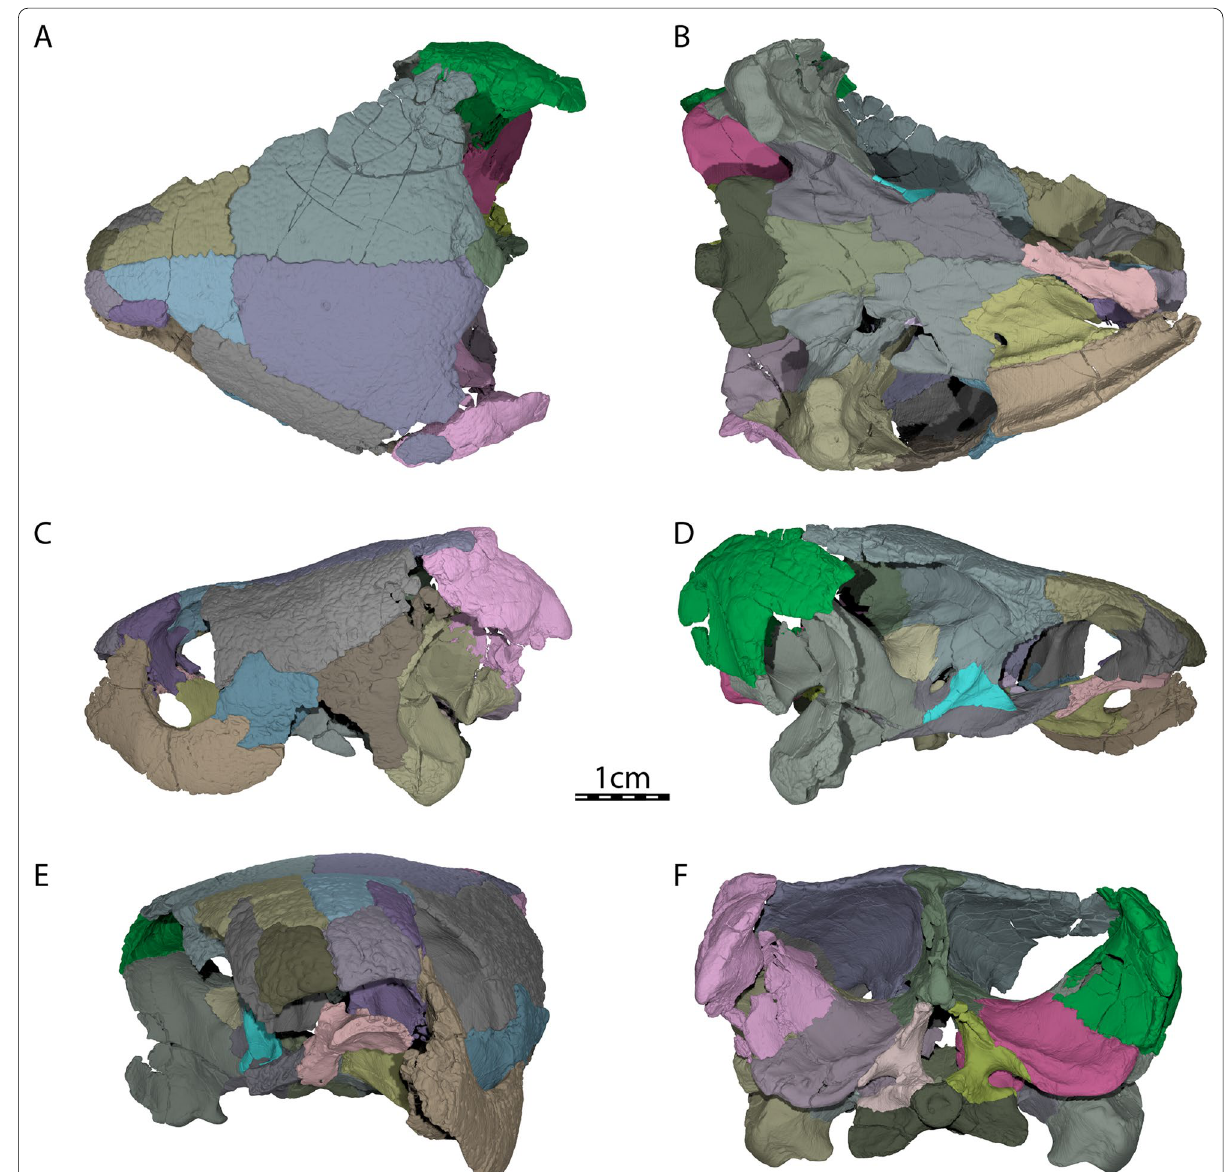
Fig. 3 Three-dimensional renderings of UCM 53971. A Dorsal view, B ventral view, C left lateral view, D right lateral view, E anterior view, and F posterior